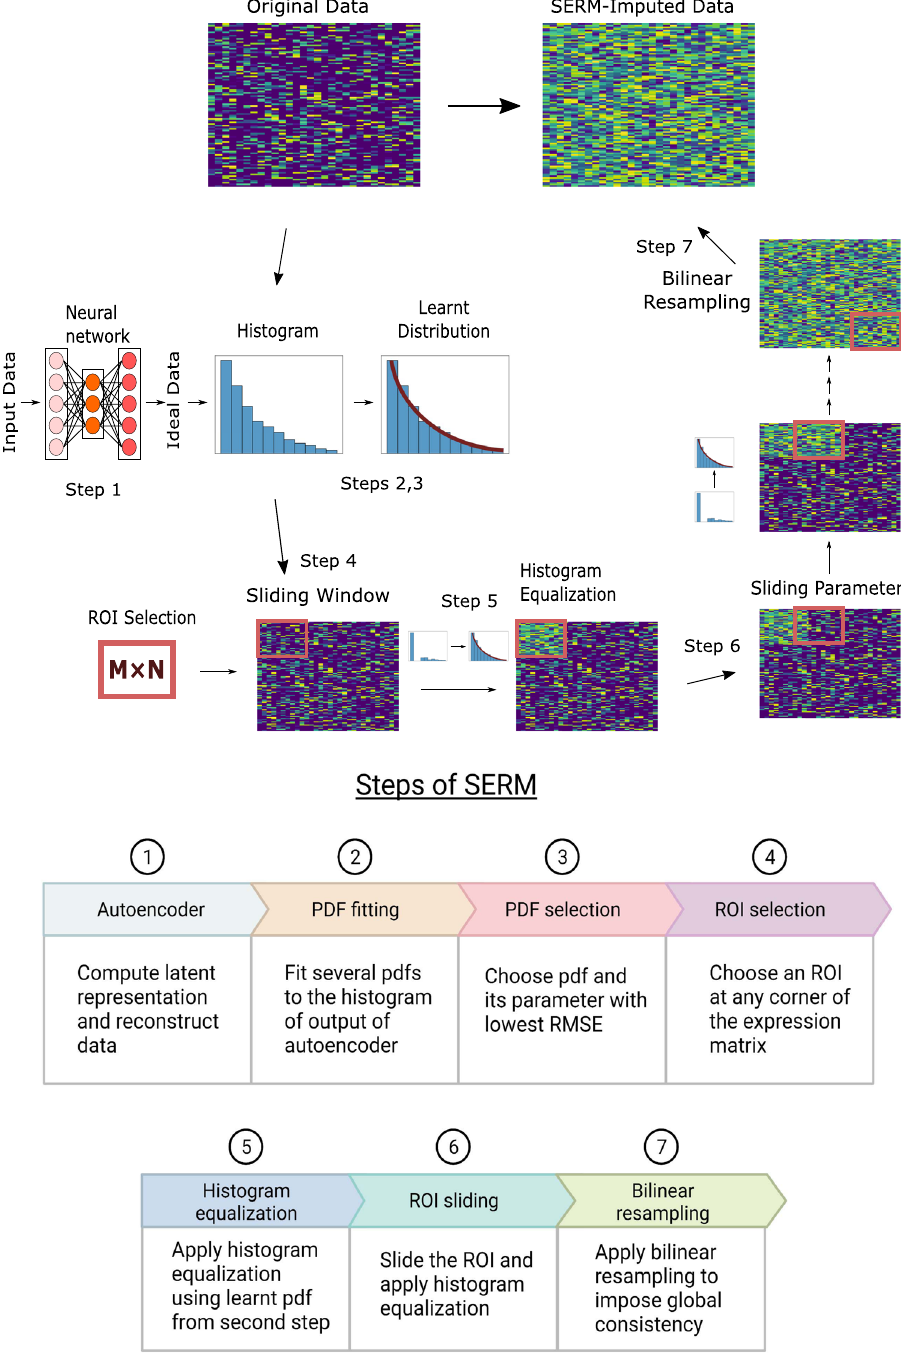
Fig. 1 | Work fl ow of SERM. A subset of the expression matrix is inputted into an autoencoder network. To learn the distribution function that best describes the reconstructeddatabytheautoencoder,differentpdfsare fi ttedtothehistogramof the reconstructed data. Next, an ROI is selected, and histogram equalization is